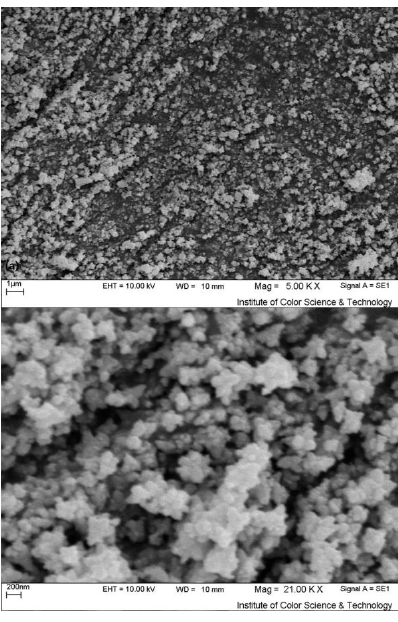
Fig. 4. SEM image of ZnS nanoparticles by NaOH. Fig. 5. SEM image of ZnS nanoparticles by TGA